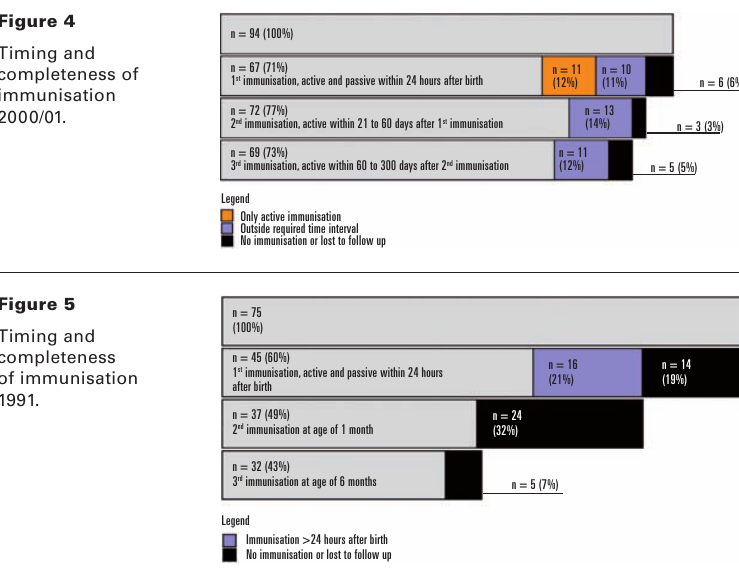
Figure 4 Timing and completeness of immunisation 2000/01.